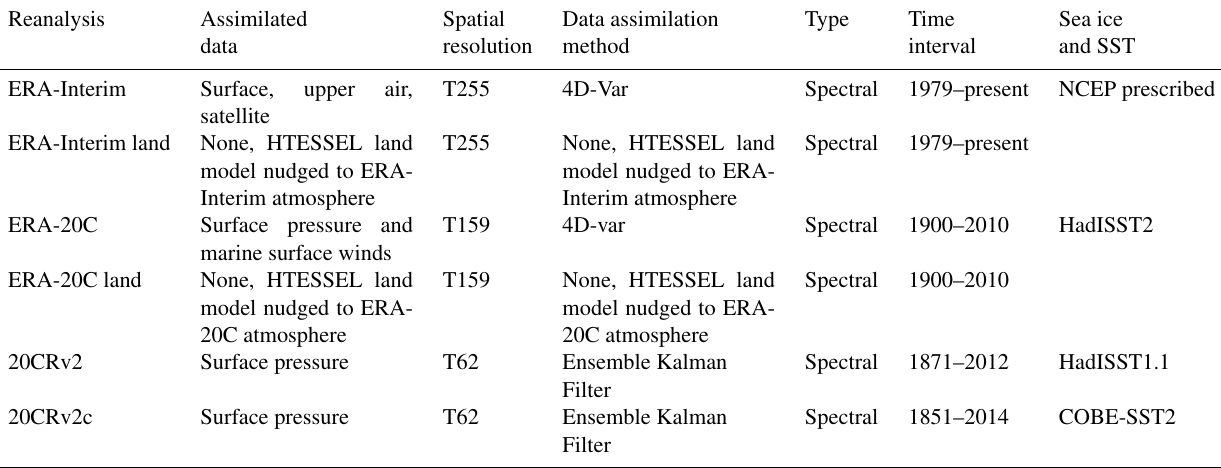
Table 1. Reanalysis product